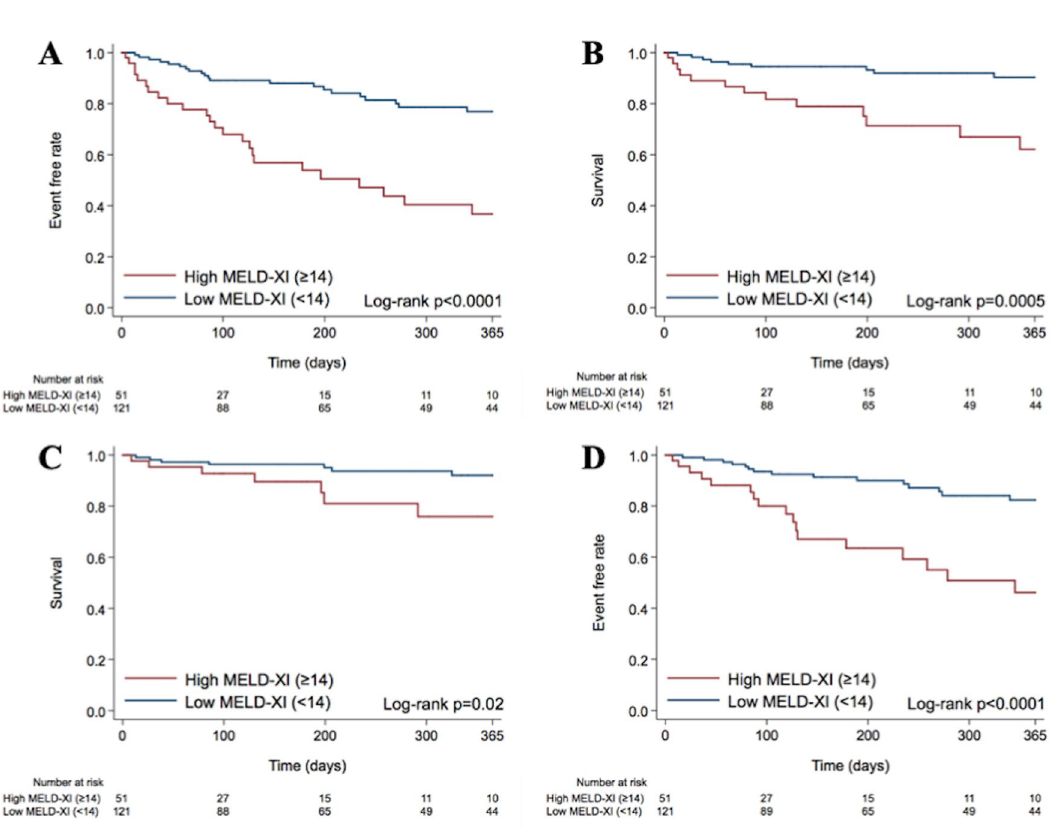
Figure 2. Clinical outcome according to the MELD-XI score within one year after TTVR. Kaplan–Meier curves demonstrating clinical outcomes within one year after TTVR, including the composite outcome ( A ), all-cause mortality ( B ), cardiovascular mortality ( C ), and HF hospitalization ( D ), according to the MELD-XI